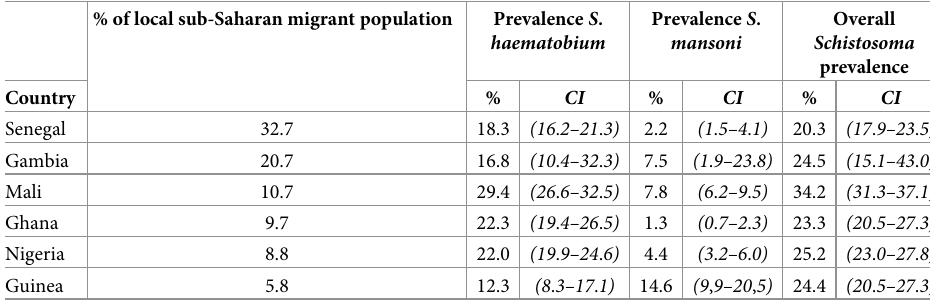
Table 1. Estimated population-adjusted prevalence of schistosomiasis in sub-Saharan African migrant communi- ties living in Catalonia, Spain, in 2012[19] 1